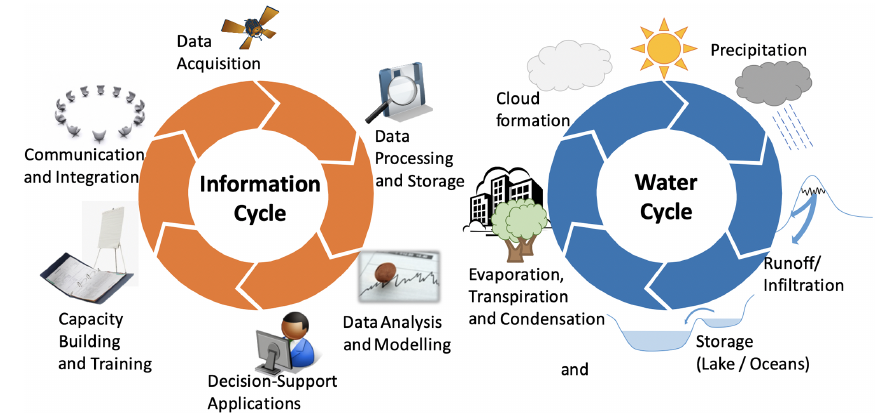
Figure 1. Information and water cycles.